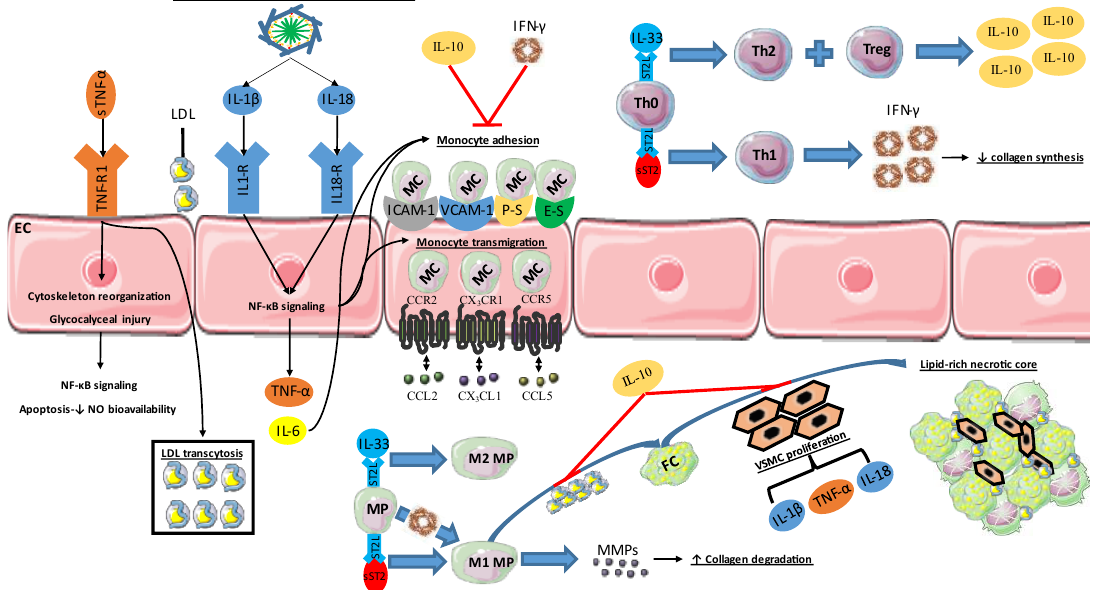
Figure 1. Role of major cytokines and chemokines in atherosclerosis initiation and progression. Cy- tokines are involved in critical steps of the atherosclerotic cascade, such as endothelial cell (EC) ac-